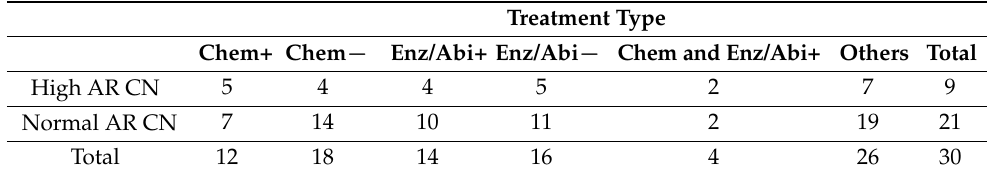
Table 4. Association of plasma AR amp+ status with